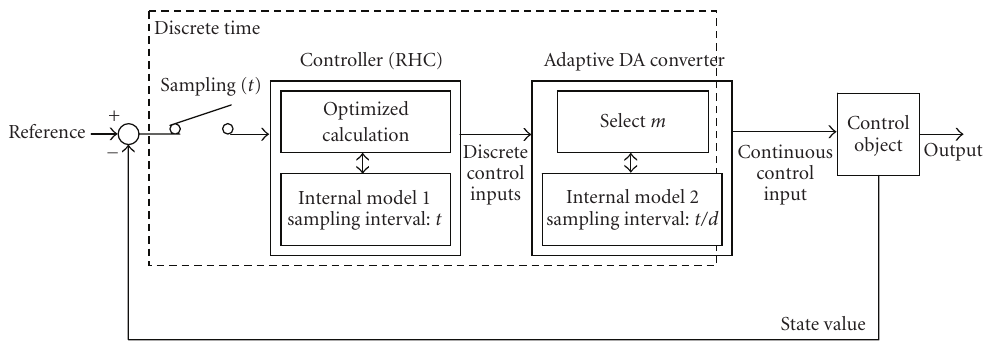
Figure 4: Proposed RHC systems with adaptive DA converter.